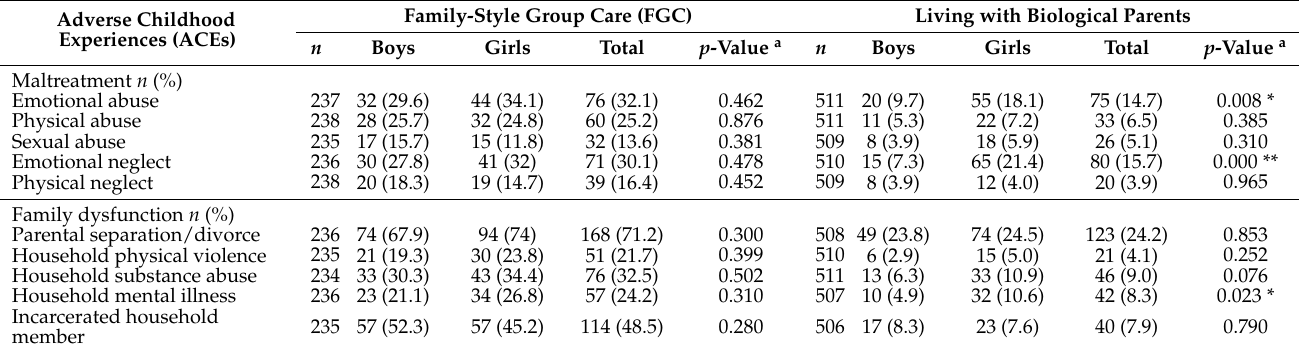
a Indicates the application of Pearson’s Chi-squared test on gender differences within population * p < 0.05, ** p <